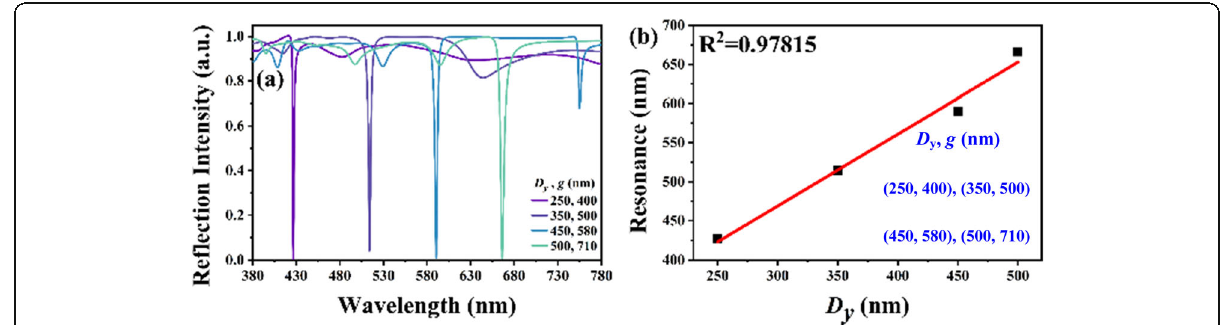
Fig. 4 a Reflection spectra of TLNM with different D y and g values. b The relationship of resonances and D y